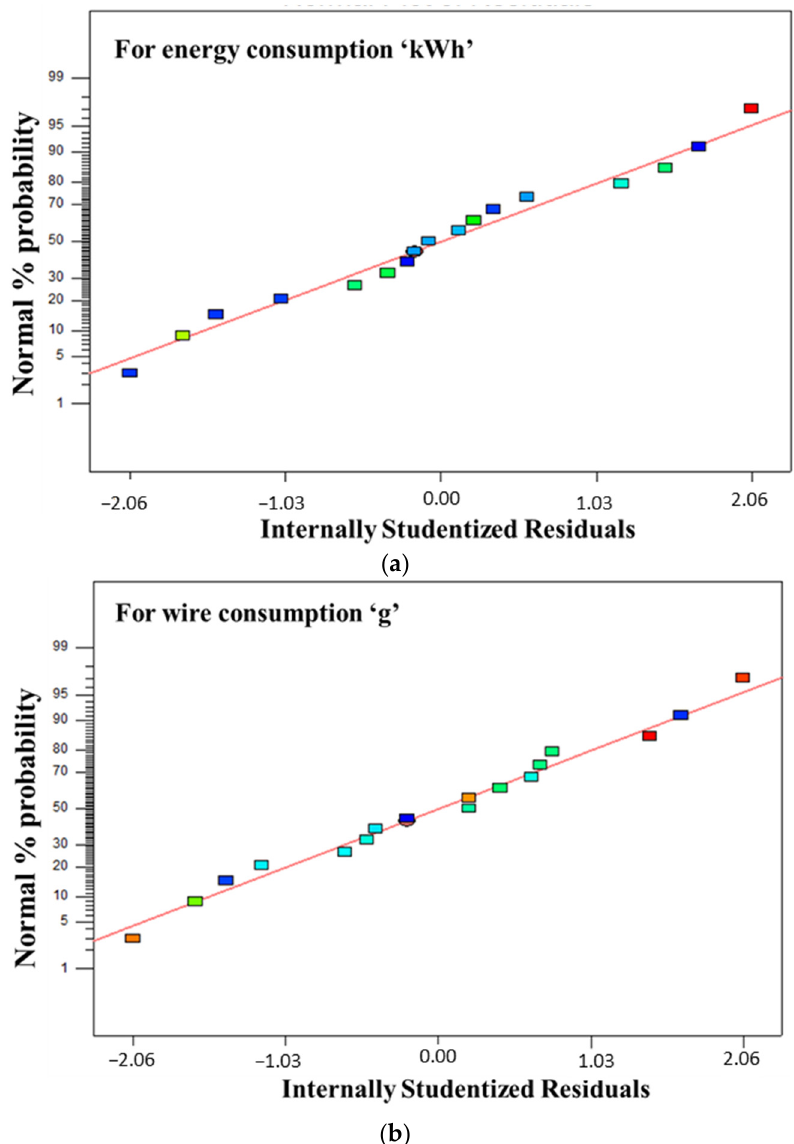
Figure A1. Normal probability distribution graphs of residuals for considered responses: ( a ) energy consumption ‘ P E ’; ( b ) wire consumption ‘ W C ’.